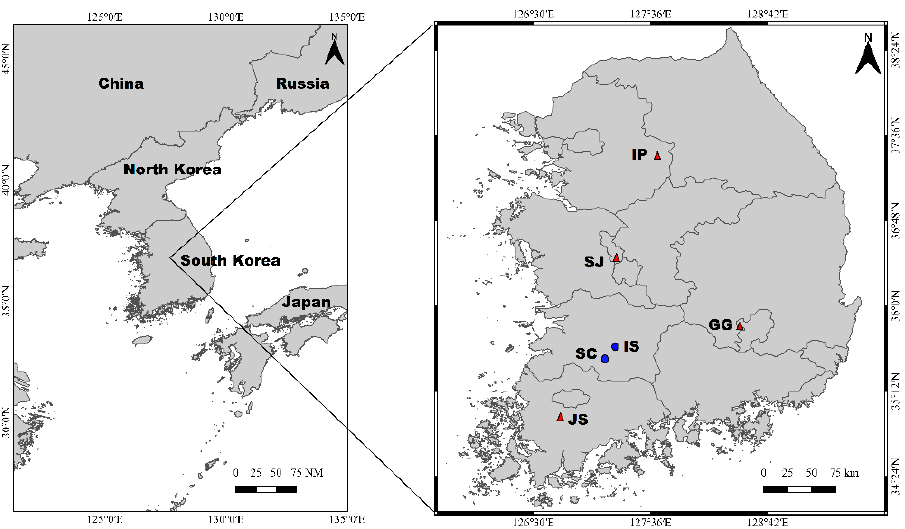
Figure 1. Sampling sites of the chironomid larvae from the rivers (SC—Sunchang and IS—Imsil, marked in blue dot) and weirs (IP—Ipo, SJ—Sejong, JS—Juksan, and GG—Gangjeong, marked in red triangle) in South Korea.